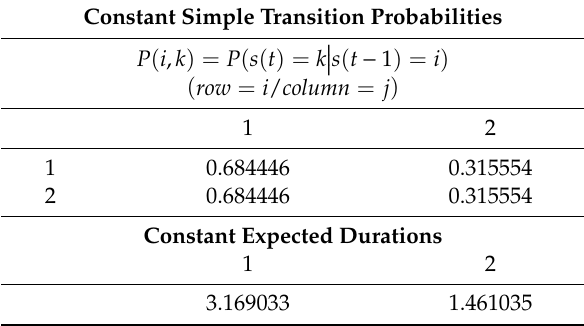
Table 5. Constant simple transition probabilities and constant expected durations of the regime-switching